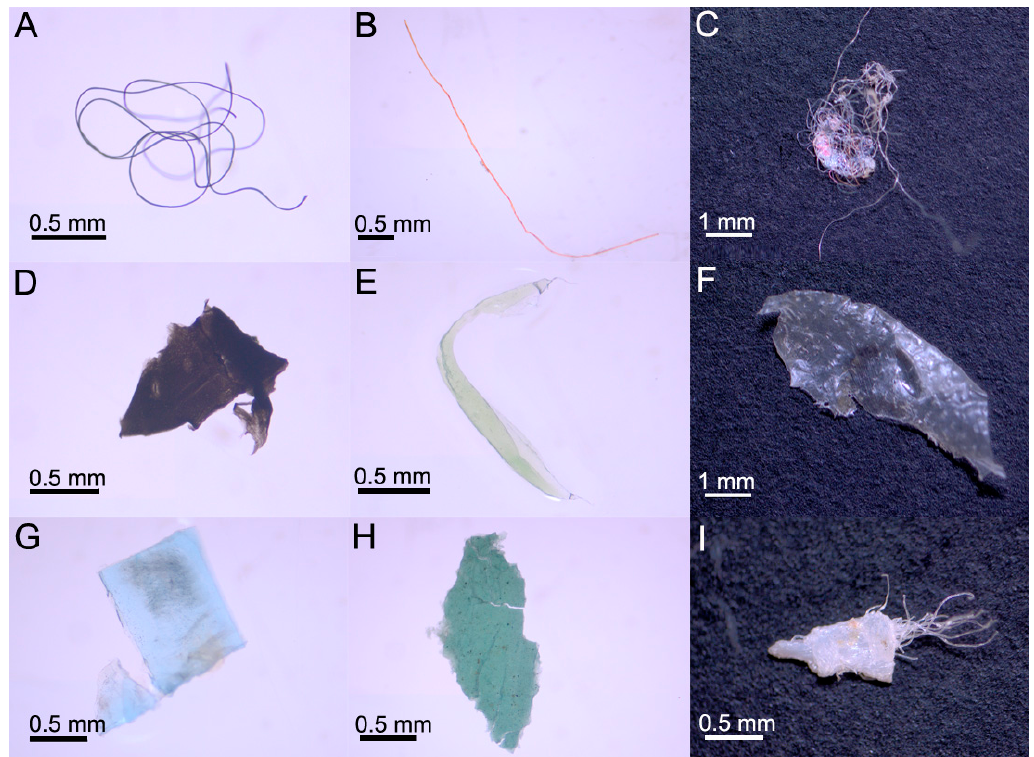
Figure 2. Examples of MPs found within the gastrointestinal tracts of Nile Tilapia and Catfish: fibers (blue polyethylene (PE) ( A ), Red polyethylene terephthalate (PET) ( B ), and PET fiber knot ( C )), films (black ( D ), green ( E ) and transparent ( F ) films were all identified as PE), and fragments (light blue polypropylene (PP) ( G ), blue-green PP (H) and white PET ( I )).